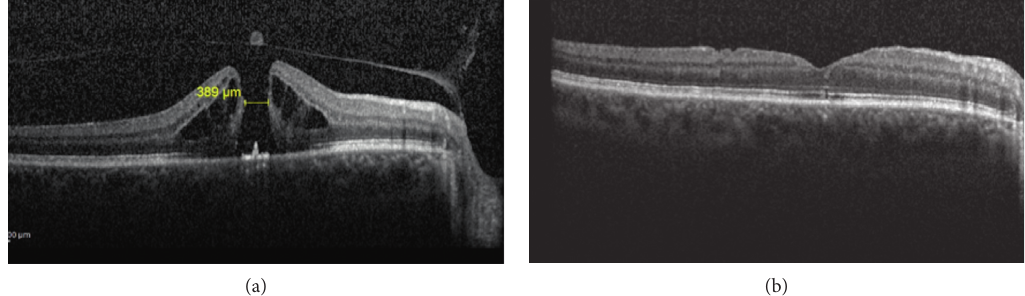
Figure 1: (a) OCT image showing stage II macular hole with a diameter of 389 μ m preoperatively. (b) OCTat 3-month follow-up showing closed MH with restored ELM and IS/OS junction integrity.